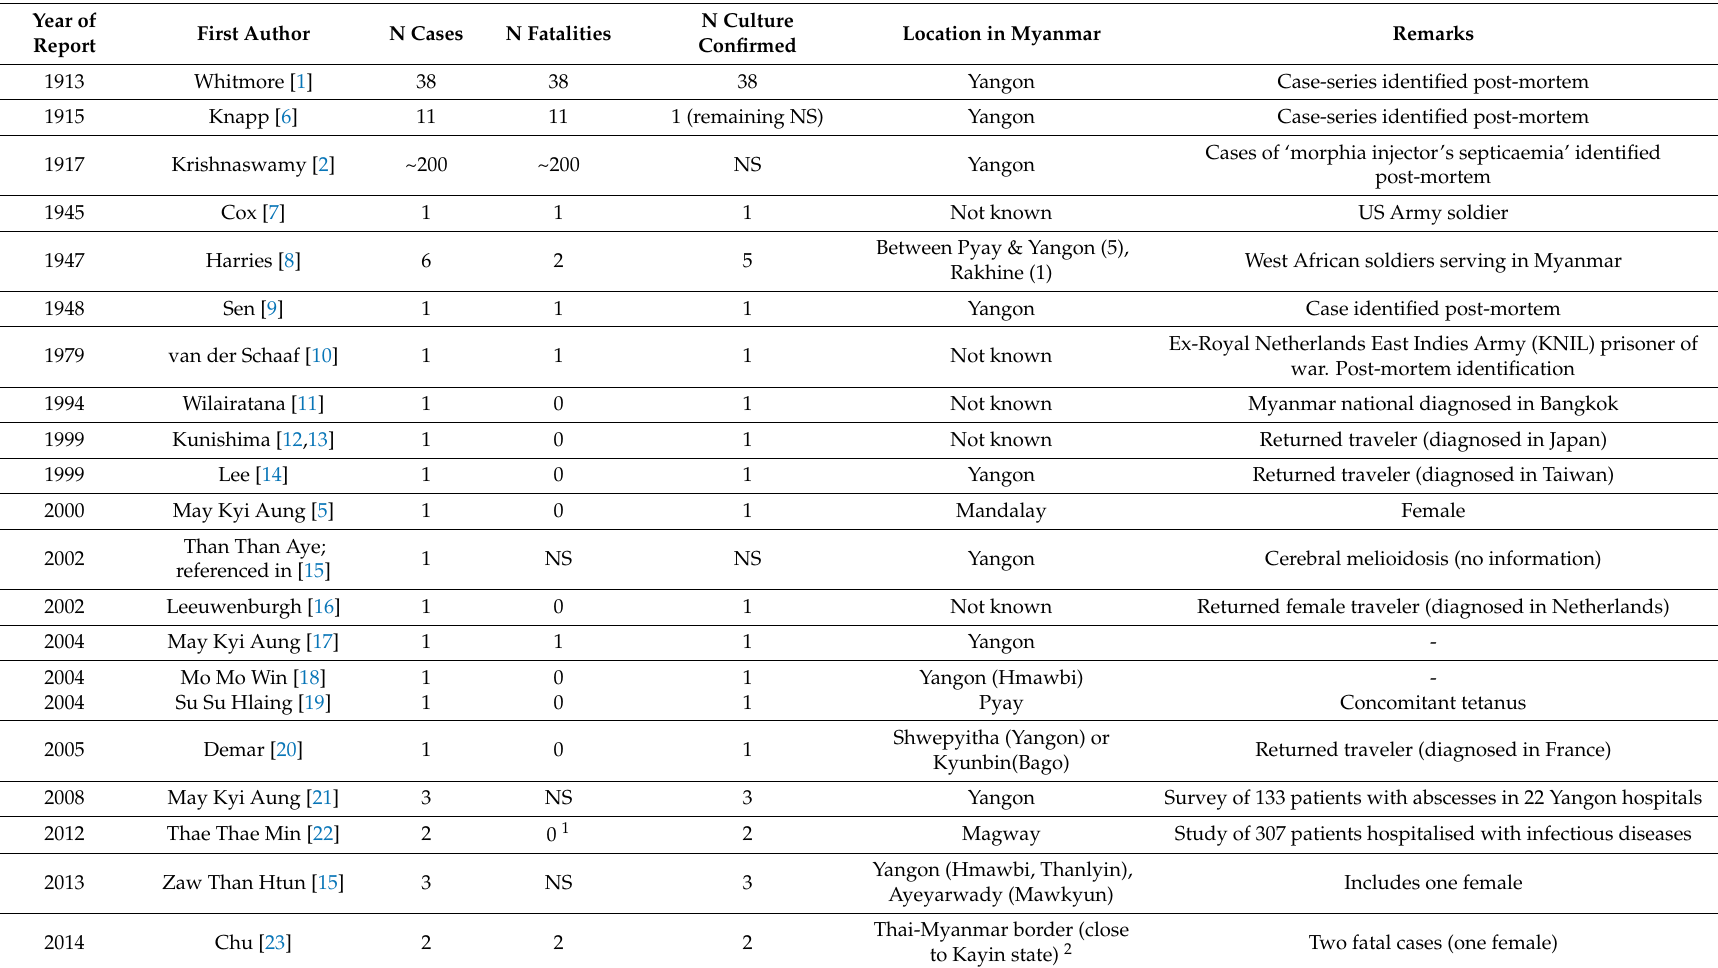
Table 1. Cases of melioidosis reported from